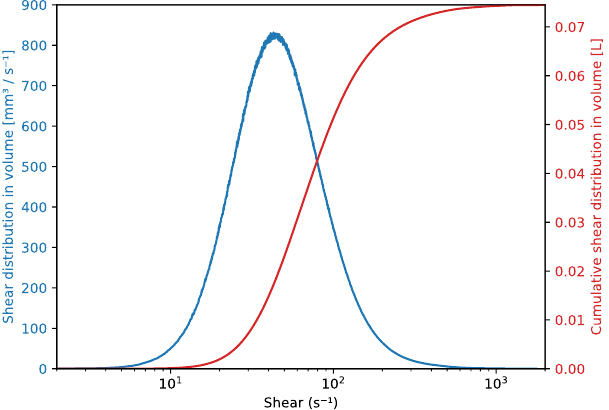
Figure 8. Shear rate distribution in volume: ∂ V / ∂ ˙ γ in blue and V ( ˙ γ ) from Equation (14) in